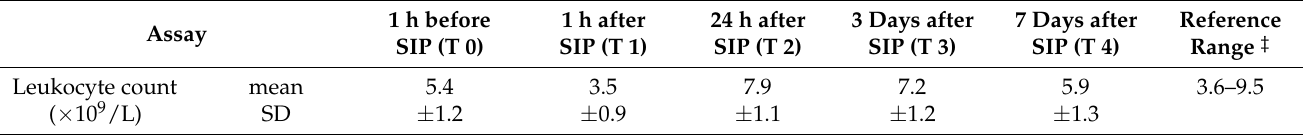
Table 1. Total leukocyte counts in the experimental sheep. Data are expressed as means and ± standard deviations (SD).